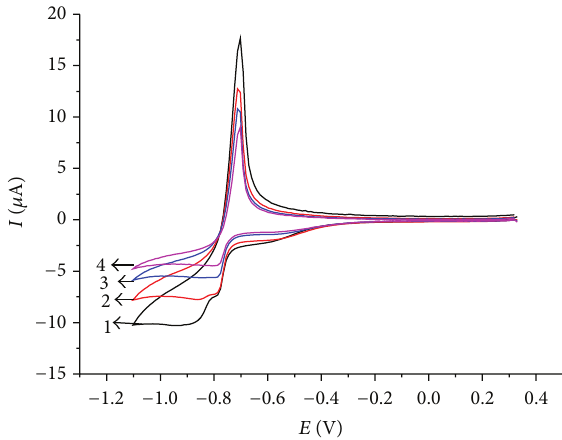
Figure 1: Cyclic voltammogram of Tl + ( 𝑐 = 10 −3 mol L −1 ) recorded with a glassy carbon electrode in the absence of oxygen (electrolyte 0.5 mol L −1 Na 2 SO 4 , pH = 7, V = 20 mV/s).